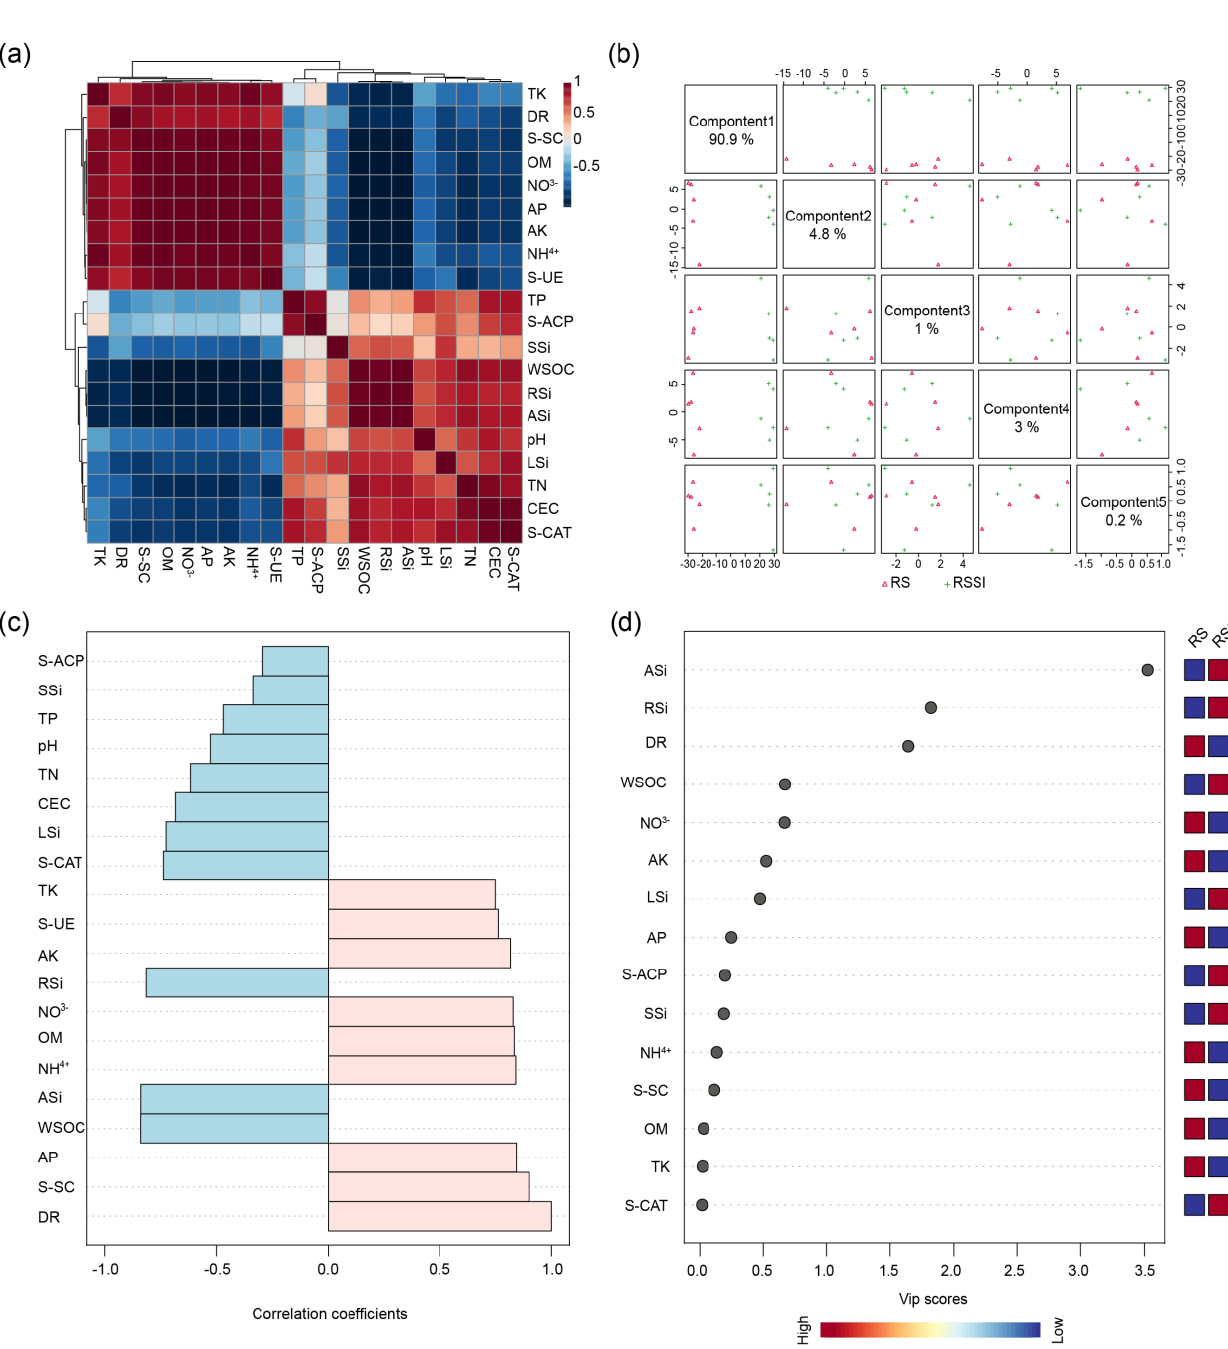
Figure 2. Impact of Si on rhizosphere soil physiochemical properties and enzymes under R. solanacearum inoculation. ( a ) Heat map for the DR and the investigated parameters. Red and blue grids represent positive and negative correlations, respectively. ( b ) Correlation of top 20 parameters with fresh weight. ( c ) Partial least squares − discriminant analysis (PLS − DA) of the 20 investigated parameters. ( d ) Variable importance in projection (VIP) to component 1 of the PLS − DA for RS and RSSI treatments.